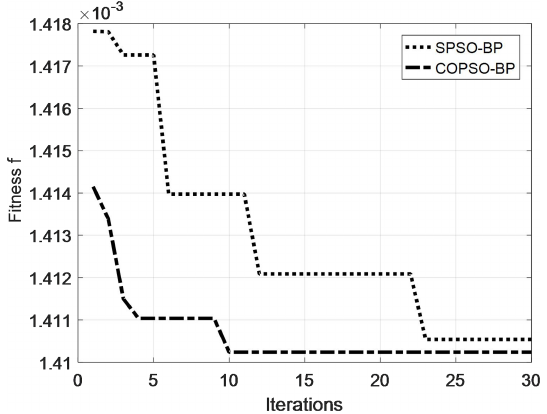
Figure 7. Fitness curves of SPSO-BP and COPSO-BP.